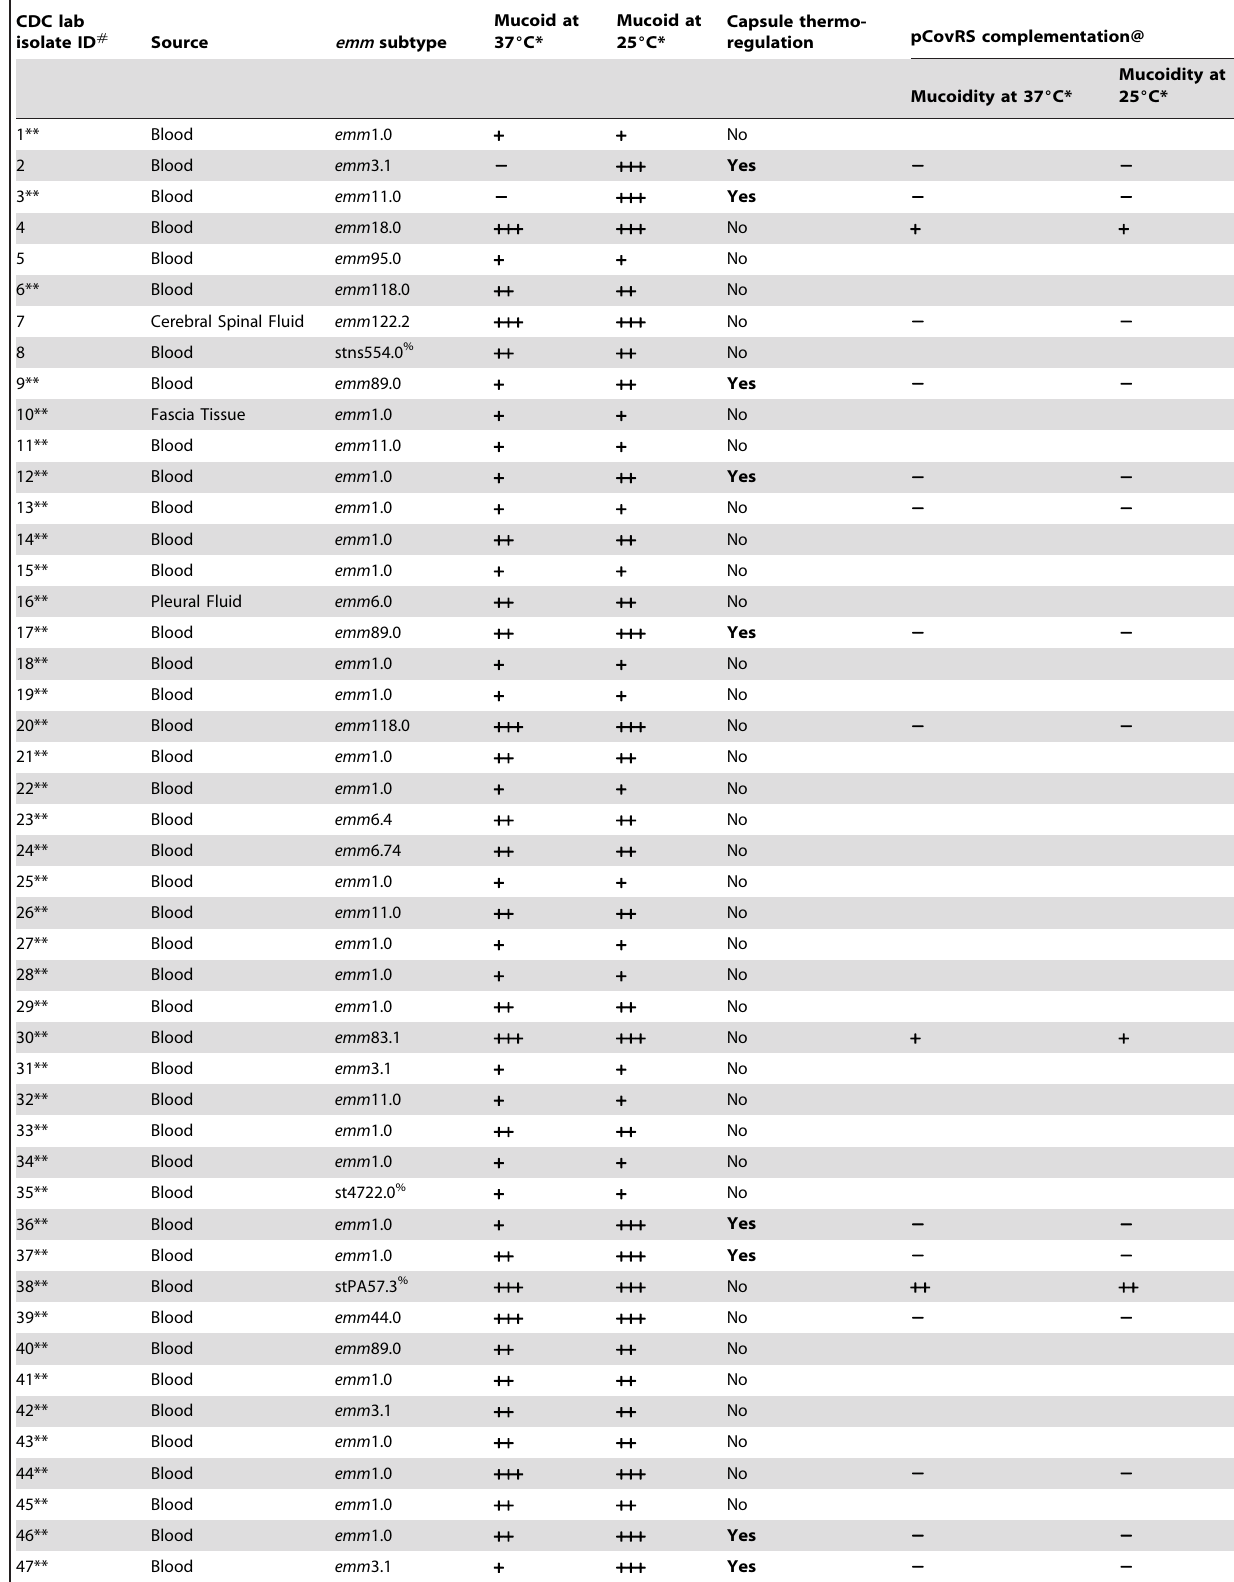
CDC lab isolate ID